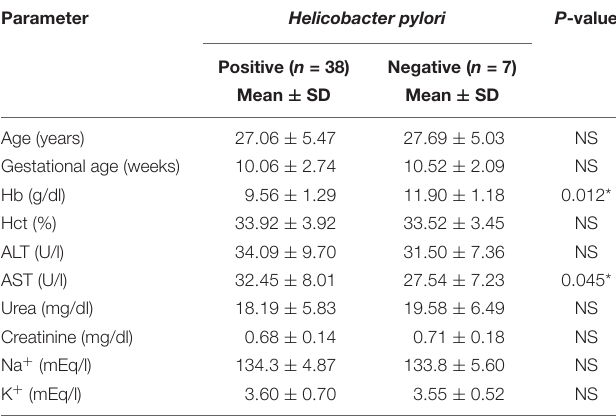
TABLE 2 | Hematological and biochemical characteristics among cases and controls.